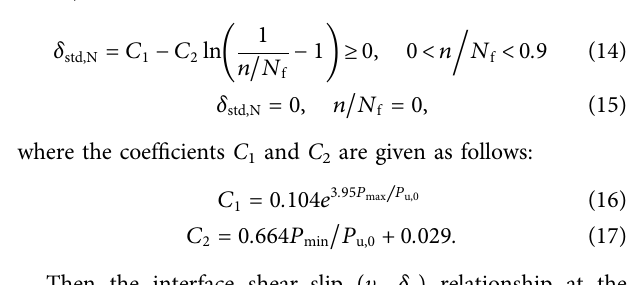
Frontiers in Materials |